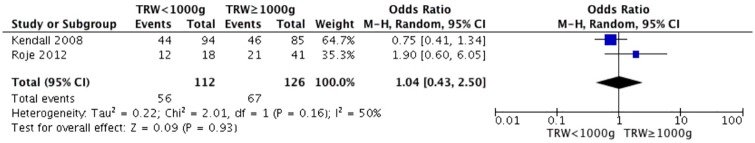
Correlations between tissue resection weight per breast and complications.